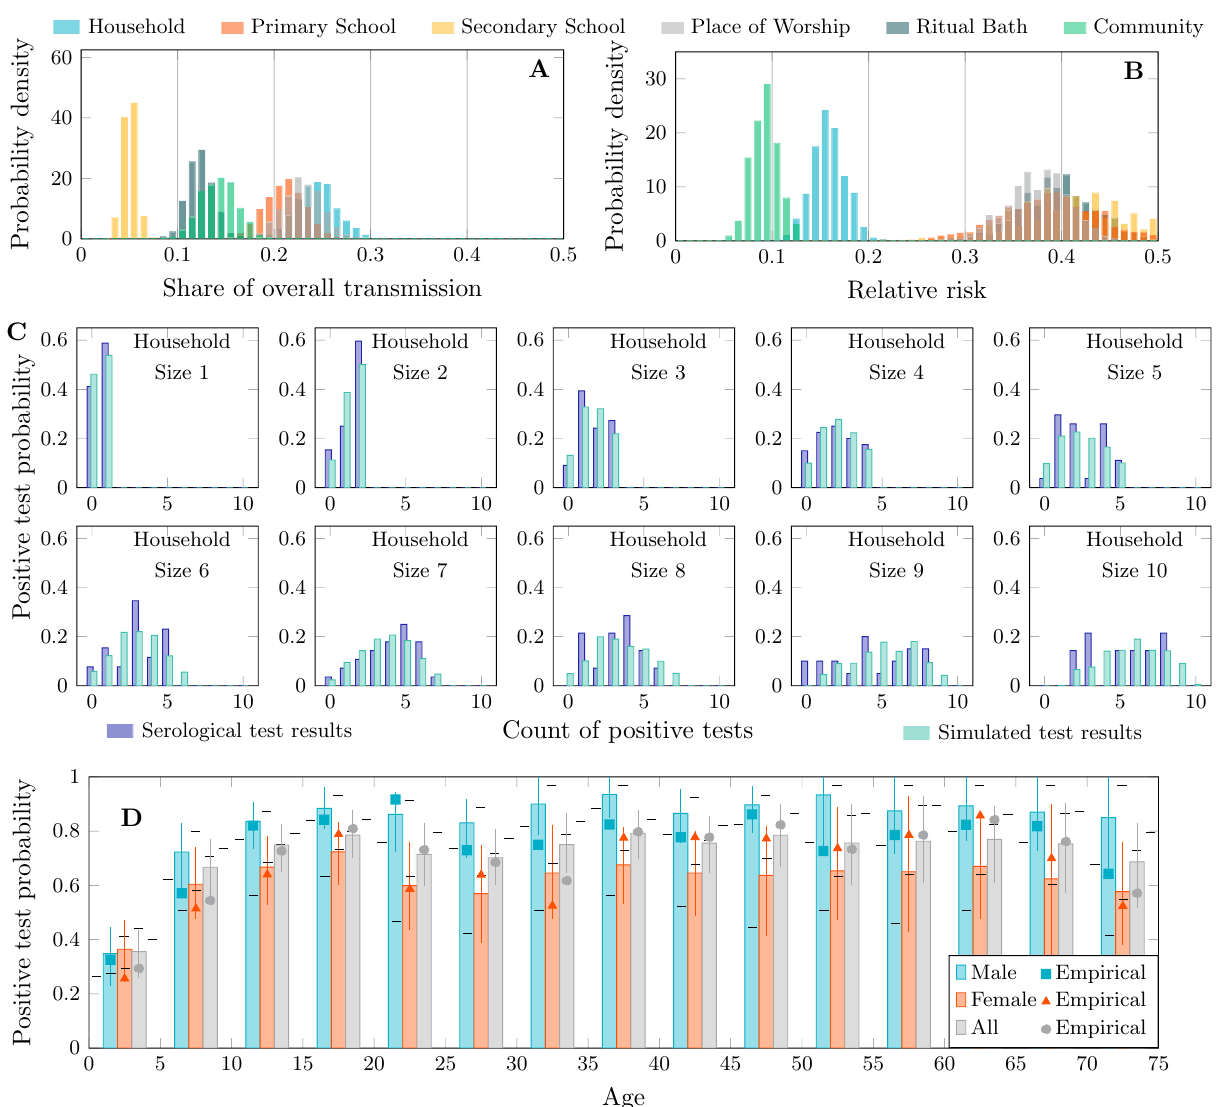
Figure 2. Transmission activity and positive test distributions. ( A ) Share of transmission attributable to different settings or location types according to the simulation. ( B ) Relative risk of transmission in different settings. This is the amount of transmission that occurred in a given setting relative to the total amount of transmission that is possible in that setting. There is a clear separation between the general community, households, and all other kinds of place. ( C ) Probability distributions of positive test results for households of size 1–10 after censoring. The observed distributions are in dark blue and simulations in light blue. ( D ) Probability of positive test result by age and sex after censoring. Square, triangle and circle marks indicate the values measured by serosurvey, error bars belong to the simulated values. Note that the model is not explicitly fitted to these data.